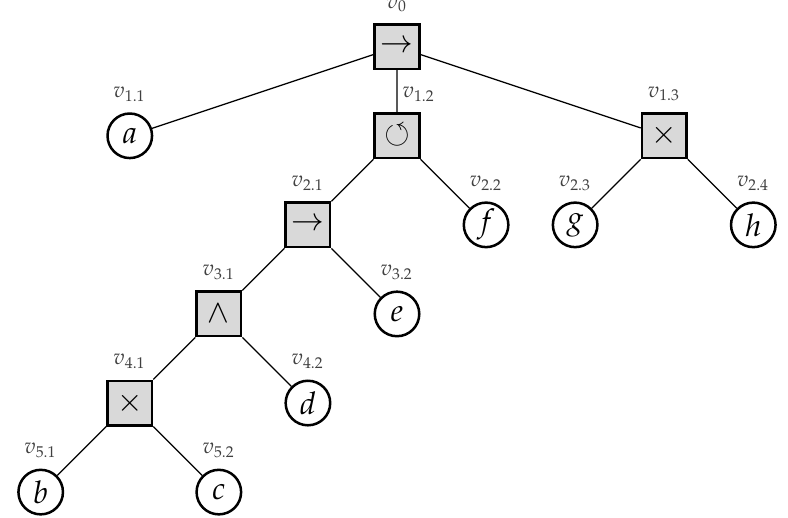
Figure 1. A simple example process tree [1], describing all basic control-flow